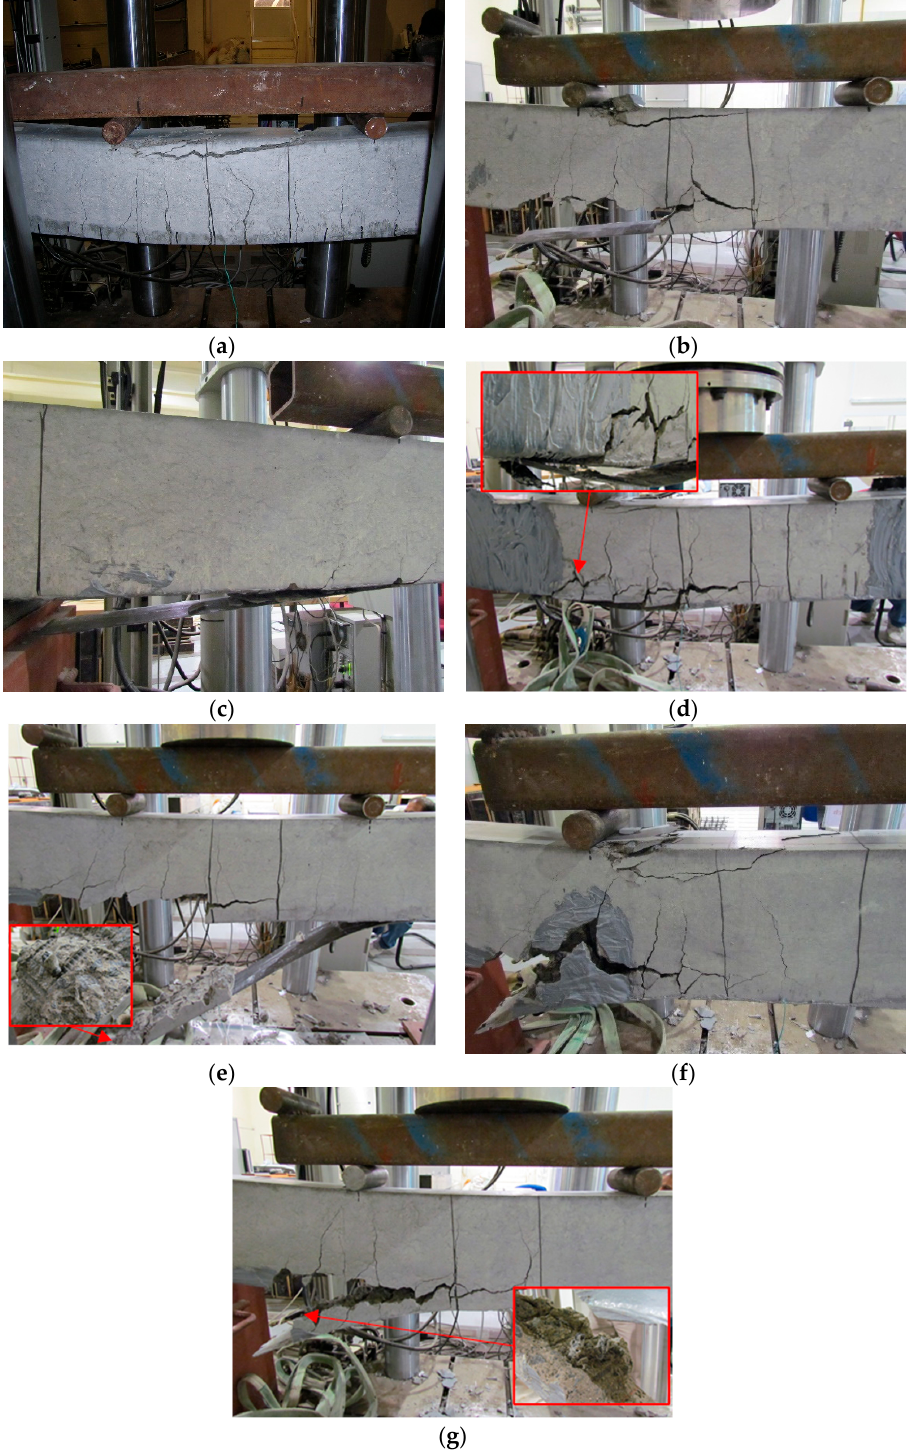
Figure 6. Failure modes of specimens: ( a ) CB; ( b ) S; ( c ) F; ( d ) S-U; ( e ) S-2A; ( f ) S-4A(d); ( g ) S-4A(s).